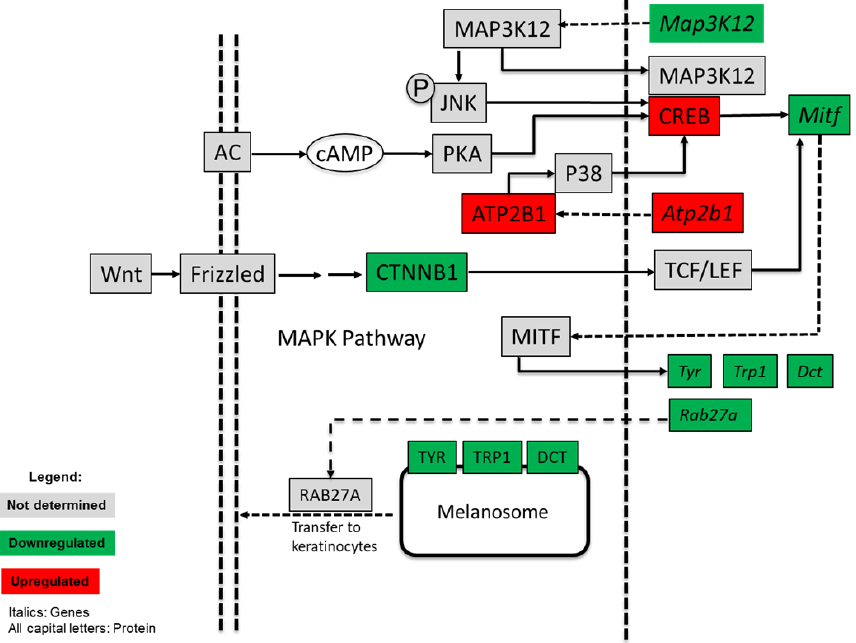
Figure 3. Argan press-cake (APC) down-regulated genes relevant to melanogenesis. This figure is adapted from Kyoto Encyclopedia of Genes and Genomes (KEGG) Pathway for melanogenesis (Available online: https://www.genome.jp/pathway/map04916 (accessed on 15 February 2021)).